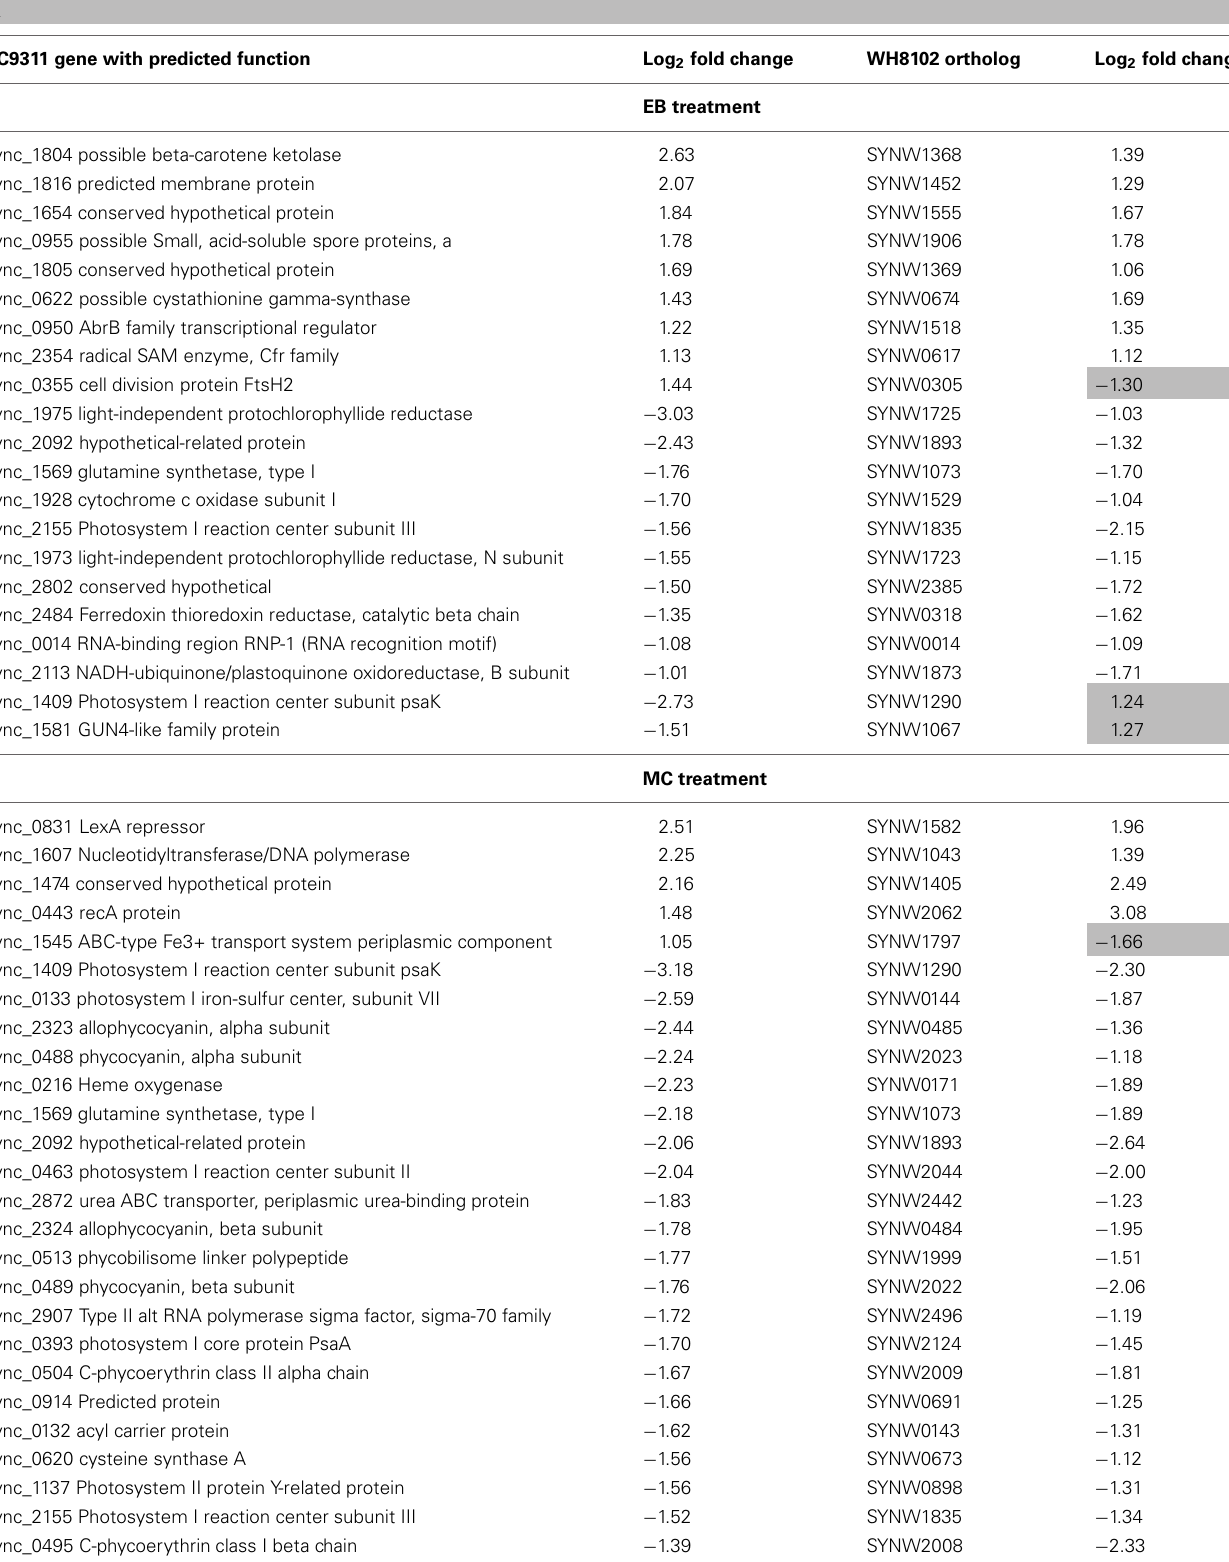
Table A1 | List of Synechococcus sp. CC9311 (A) and WH8102 (B) orthologous genes which showed strong (more than 2-fold) up- or downregulation in both strains in EB or MC